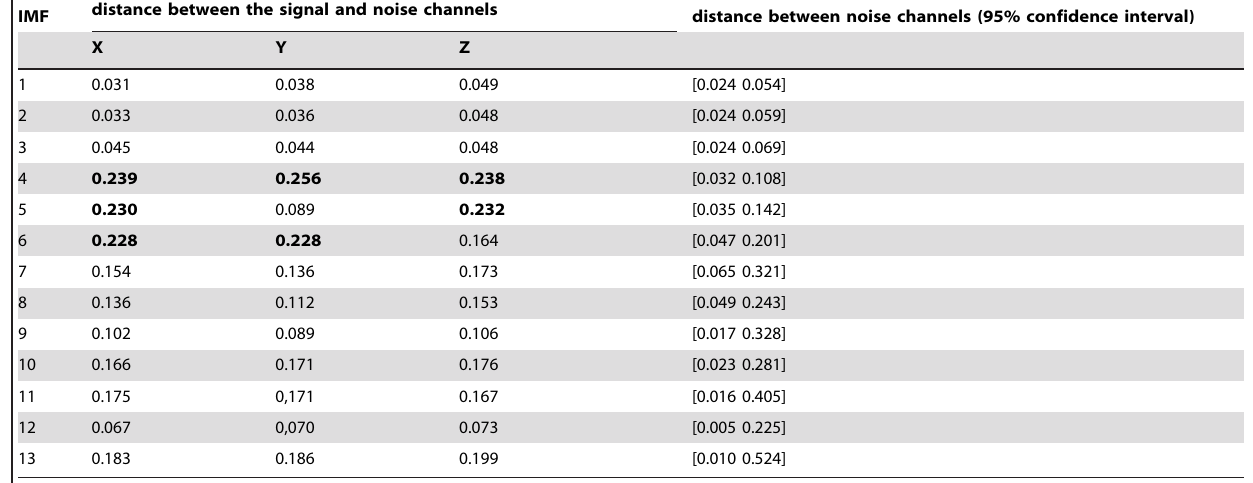
Table 1. Statistical identification of significant information-bearing IMFs by the Wasserstein distance.